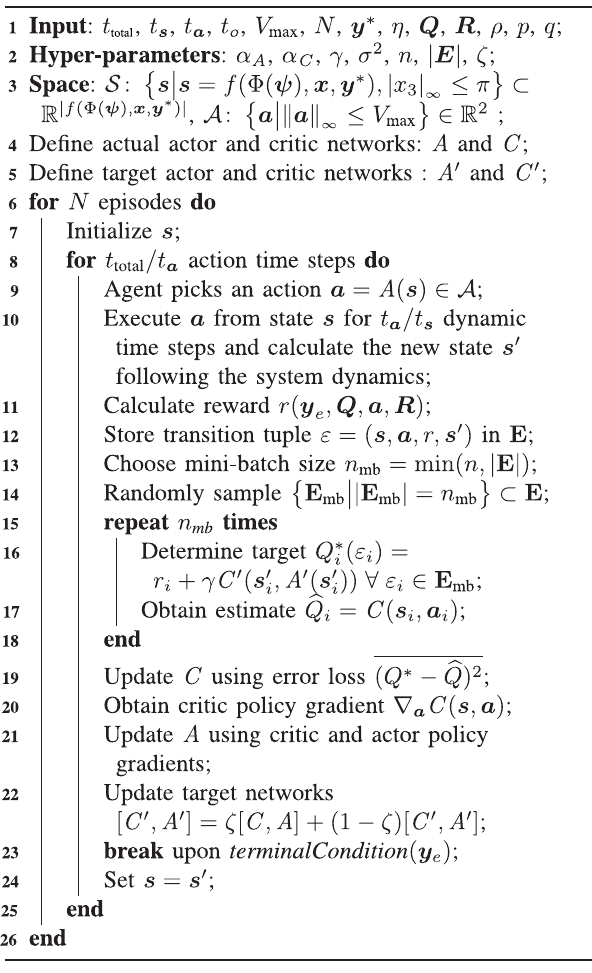
Algorithm 1. Deep-Deterministic Policy Gradient Learning in Soft Robotic